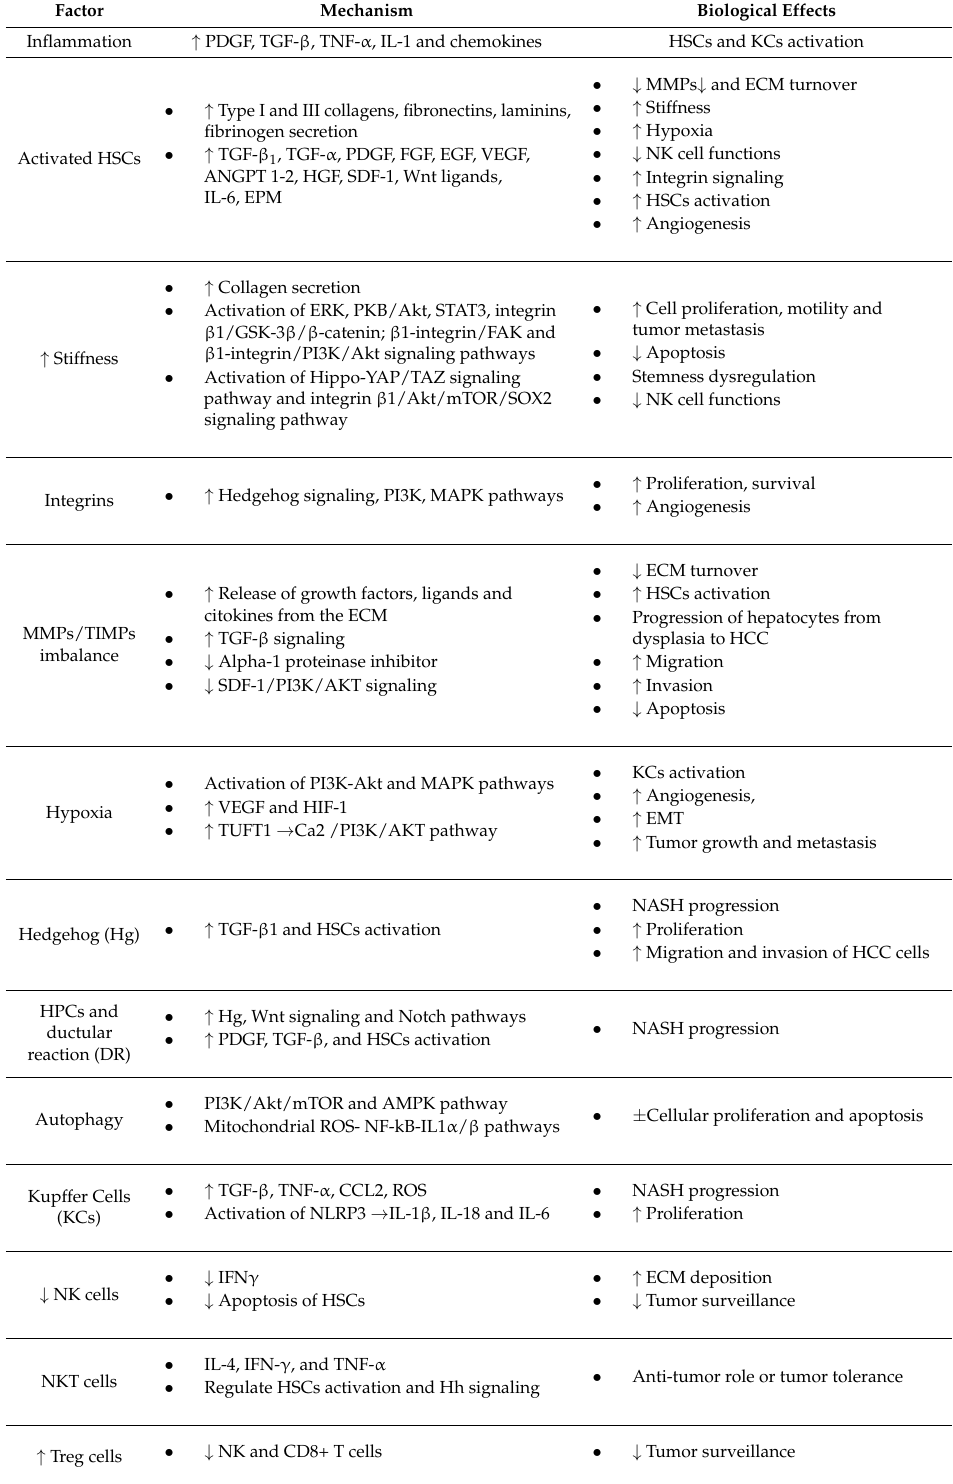
Hh, Hedgehog; PDGF, platelet derived growth factor; TGF- β , transforming growth factors- β ; TNF- α , tumor necrosis factor- α ; IL-1, interleukin-1; HSCs, hepatic stellate cells; ECM, extracellular matrix; PI3K, phosphatidylinositol 3-kinase; EGF, epidermal growth factor; MMPs, matrix metalloproteinases; TIMPs, tissue inhibitor of metalloproteases; VEGF, vascular endothelial growth factor; HIF-1, hypoxia-inducible factor 1; ANGPT, angiopoietin; HPCs, Hepatic progenitor cells; EPM,